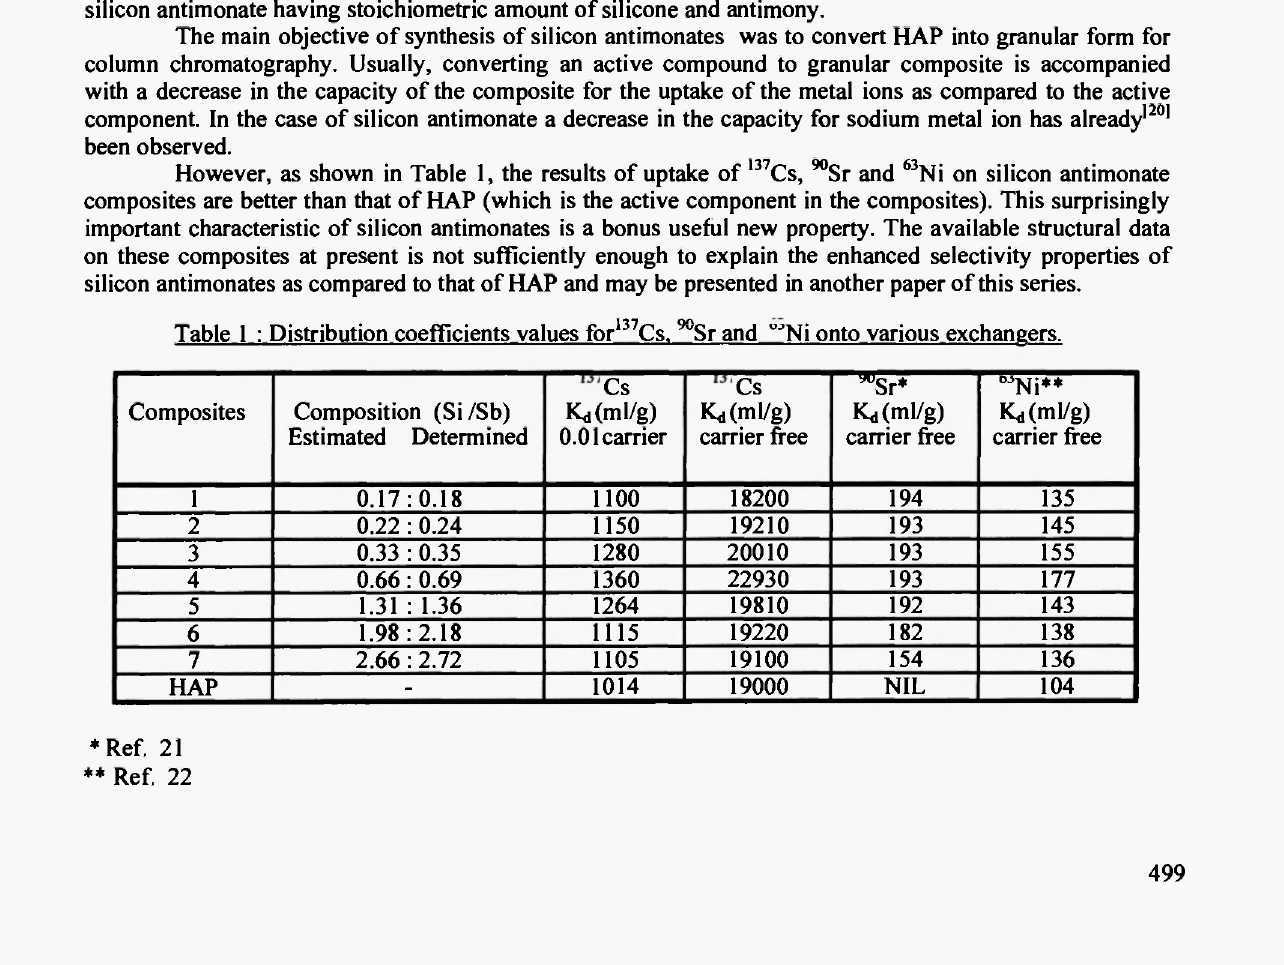
ΟΛ Table 1 : Distribution coefficients values for Cs. Sr and Ni onto various